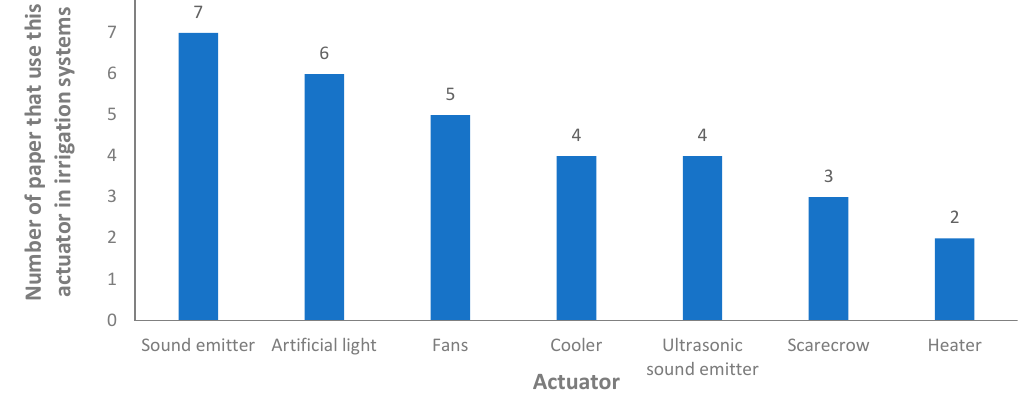
Figure 10. Used actuators in papers that propose an irrigation system.